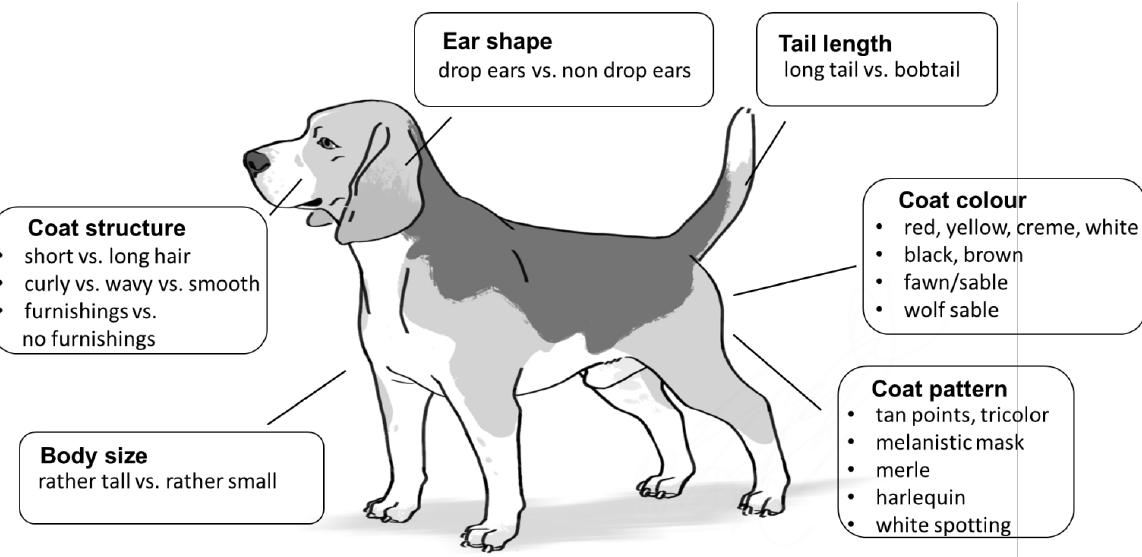
Figure 1. Schematic illustration of the trait categories selected to deduce a dog’s appearance by applying canine DNA phenotyping. The six trait categories include the most obvious characteristics of a dog that can easily be recognized and described even by an untrained eyewitness. Each box refers to one trait category and contains clearly distinguishable externally visible characteristics predictable from a particular genotype. The listings should provide an overview of the standardized terminology used here to characterize the appearance. vs.—versus (picture copyright: Larissa